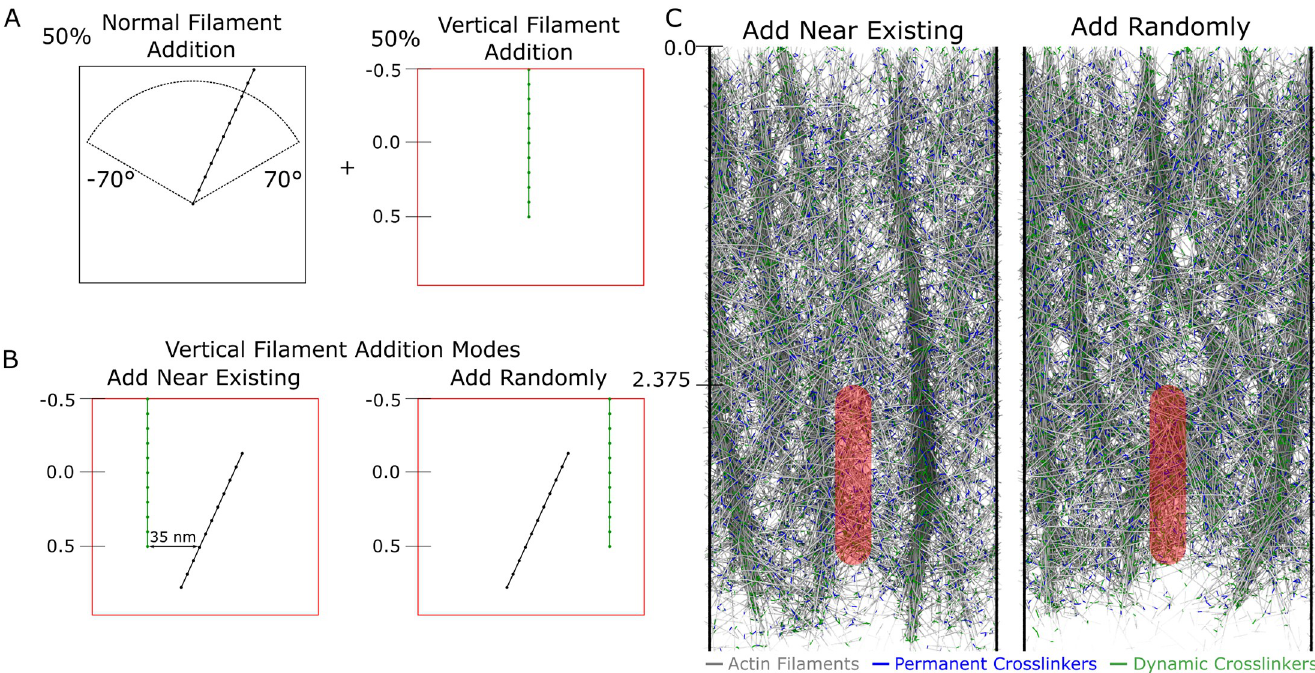
Fig 7. Vertical filament bundles reminiscent of microspikes form if the method of filament addition is modified. Retrograde flow simulations show microspike- like bundles when focal adhesion with κ = 250 with top edge at y = 2.375 μm , and uniform pulling is applied, as in Fig 6. The concentration of dynamic crosslinkers FA was fixed at 10 μM . (A) Schematic of vertical filament addition mode: half of filaments added initially have a vertical orientation while the remaining half are added with initial orientation between -70˚ and 70˚ as shown in prior figures. (B) Vertical addition occurs with filaments either added with their pointed ends 35 nm away from existing filaments along the x direction, or at a random x position. (C) Steady state simulation snapshots. Vertical filament addition either near existing filaments or randomly results in vertical filament bundles similar to microspikes, with the “near existing” filament addition mode resulting in tighter bundles. The scale along the vertical ( y ) axis is in μm . Blue (green) line segments represent permanent (dynamic) crosslinkers. Simulation snapshots taken after 275 s of simulation time.